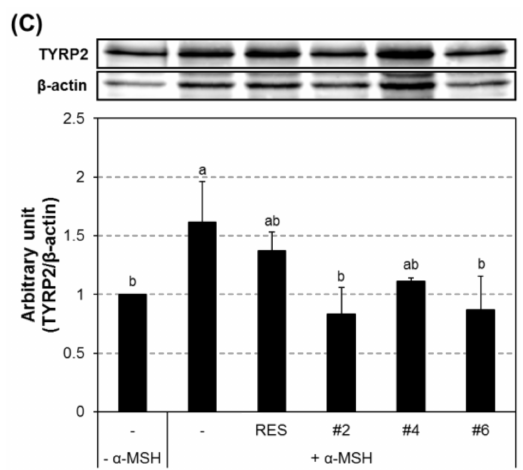
Figure 6. Melanogenic protein expression in the compound-treated B16F10 cells. The cells were treated with the indicated compound at 2 µ M concentration for 24 h. Relative protein expression levels of cytoplasmic TYR ( A ), TYRP1 ( B ), and TYRP2 ( C ) were determined by western blot analysis. α -MSH, alpha-melanocyte-stimulating hormone (10 nM); RES, resveratrol (10 µ M); TYR, tyrosinase; TYRP1, tyrosinase-related protein 1; TRYP2, tyrosinase-related protein 2. n = 3; error bars, mean ± SEM. Different alphabetical letters indicate significant differences among the conditions ( p < 0.05).